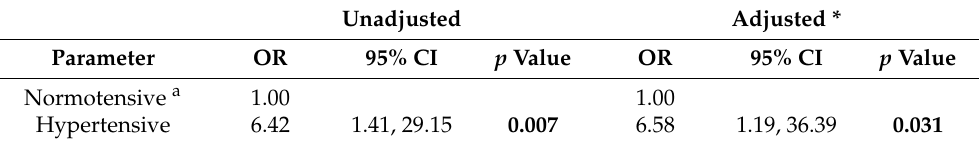
Table 2. Unadjusted and adjusted * odds ratios of having microalbuminuria by hypertension status. Unadjusted Adjusted *